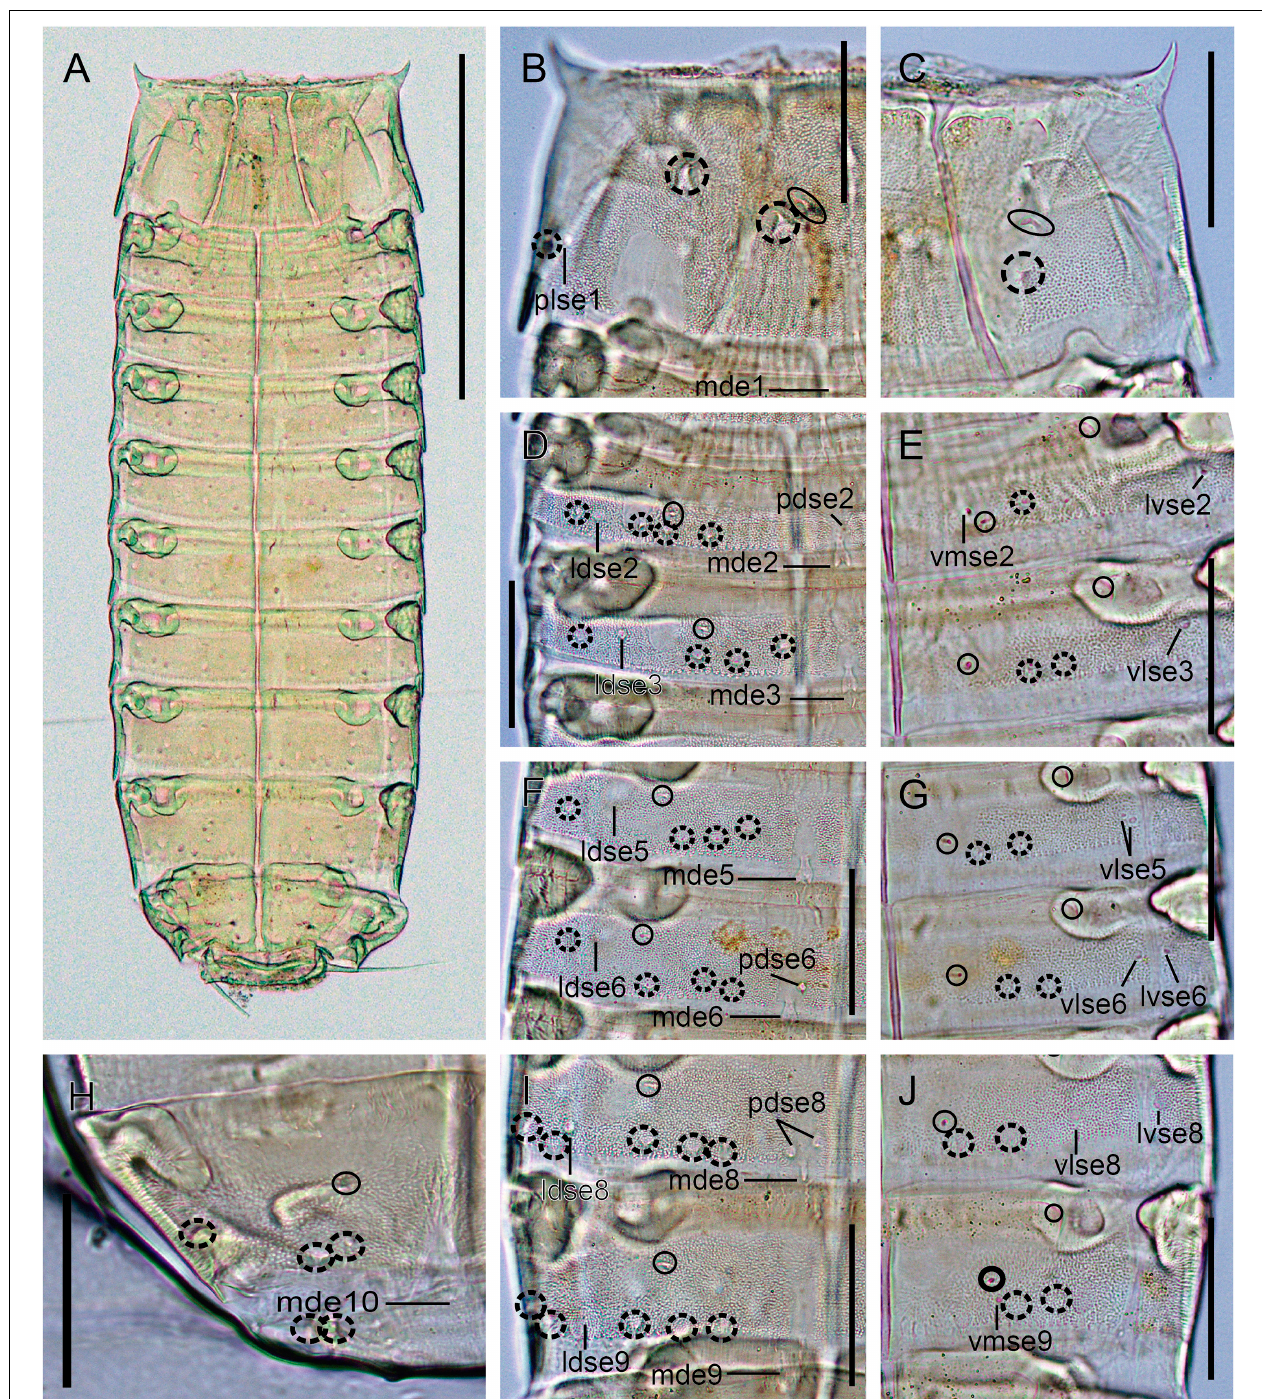
FIGURE 6 | Light micrographs showing trunk overview and details in the main trunk cuticular appendages of female holotype NHMD 669766 of Fujuriphyes hydra sp. nov. (A) Ventral overview of trunk; (B) middorsal to paralateral view on right half of tergal plate of segment 1; (C) ventrolateral to ventromedial view on left half of sternal plates of segment 1; (D) middorsal to laterodorsal view on right half of tergal plates of segments 2–3; (E) left sternal plates of segments 2–3; (F) middorsal to laterodorsal view on right half of tergal plates of segments 5–6; (G) left sternal plates of segments 5–6; (H) middorsal to laterodorsal view on right half of tergal plate of segment 10; (I) middorsal to laterodorsal view on right half of tergal plate of segments 8–9; (J) left sternal plates of segments 8–9. Scale bars: (A): 250 µ m; (B–J) : 62 µ m. Abbreviations: ldse, laterodorsal seta; mde, middorsal elevation; pdse, paradorsal seta; plse, paralateral seta; vlse, ventrolateral seta; vmse, ventromedial seta; numbers after abbreviations indicate corresponding segment; sensory spots are marked as dashed circles (except paradorsal ones), and glandular cell outlets as closed circles.